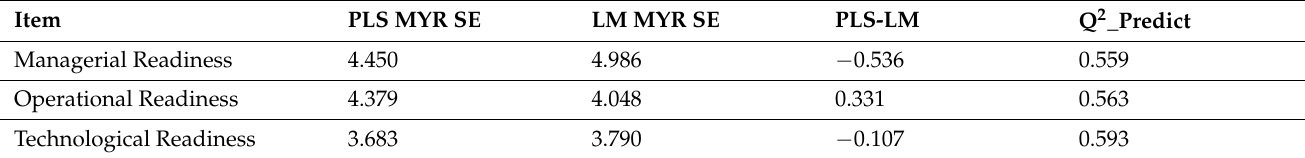
Table 16. PLS predictive